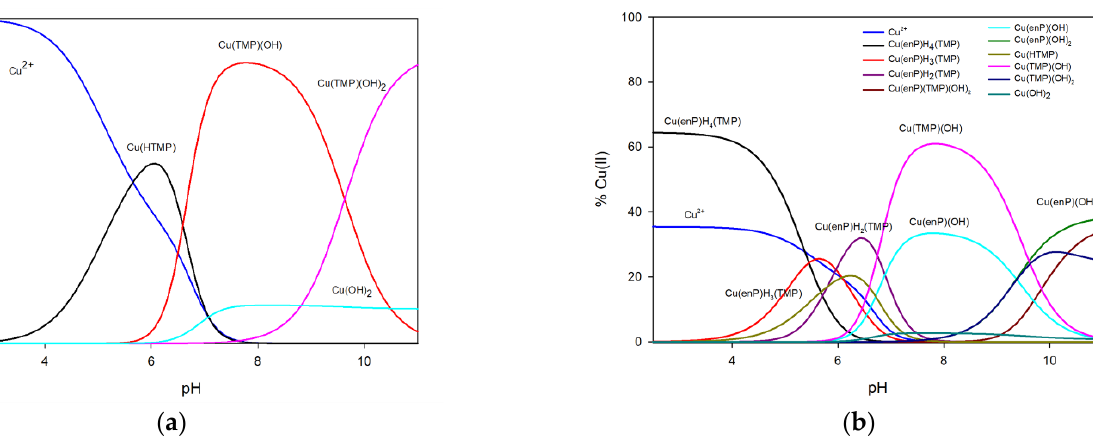
Figure 2. Distribution diagrams for ( a ) Cu(II)/TMP and ( b ) Cu/enP/TMP system (C Cu = C enP = C TMP = 1.0 × 10 − 3